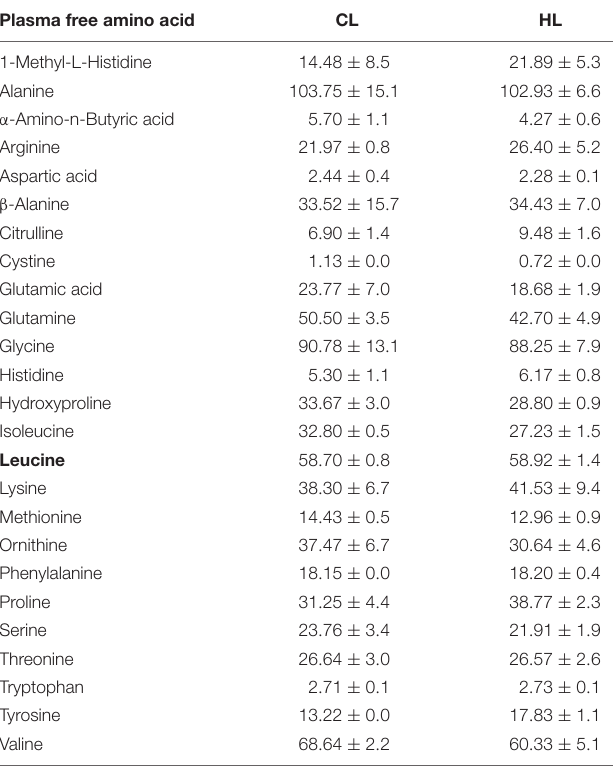
TABLE 3 | Plasma free amino acid ( µ mol/100 mL) in fish fed diets with control (standard) leucine (CL; 27.3 g/kg) or high leucine (HL; 35 g/kg) levels. Plasma free amino acid